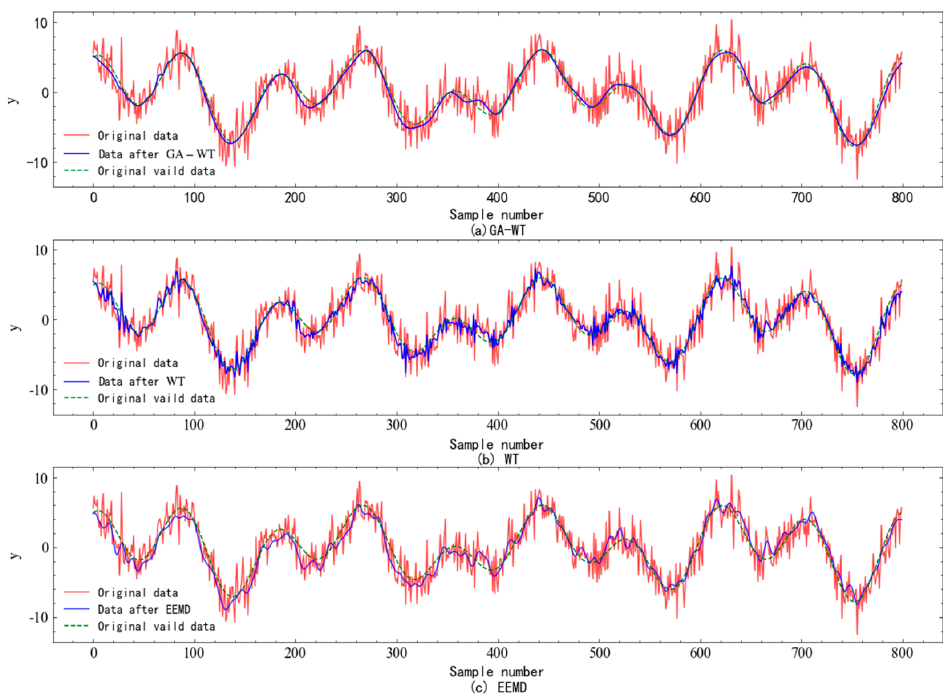
Figure 4. Comparison of the three methods.